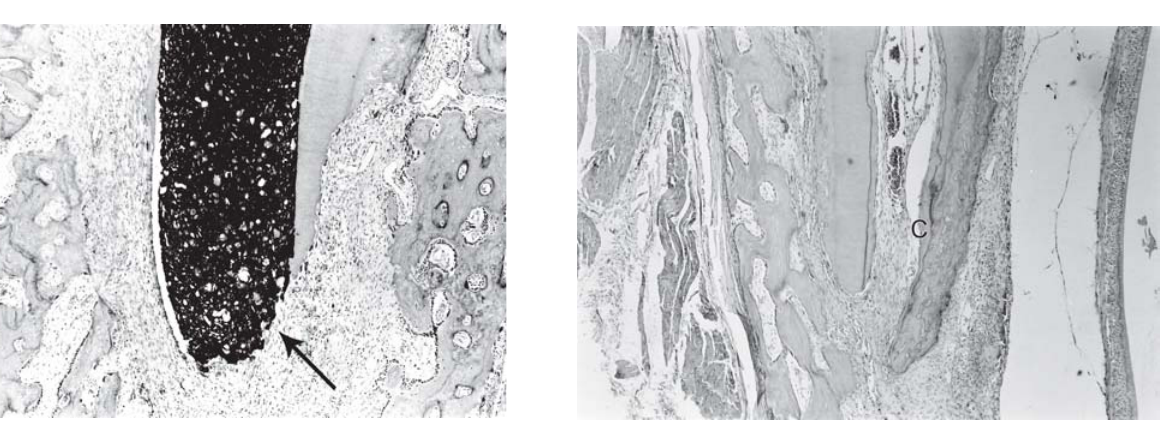
FIGURE 8 - Control group. There is newly formed cementum (C) on the walls of the root canal along with ingrowth of periodontal connective tissue. H.E. X